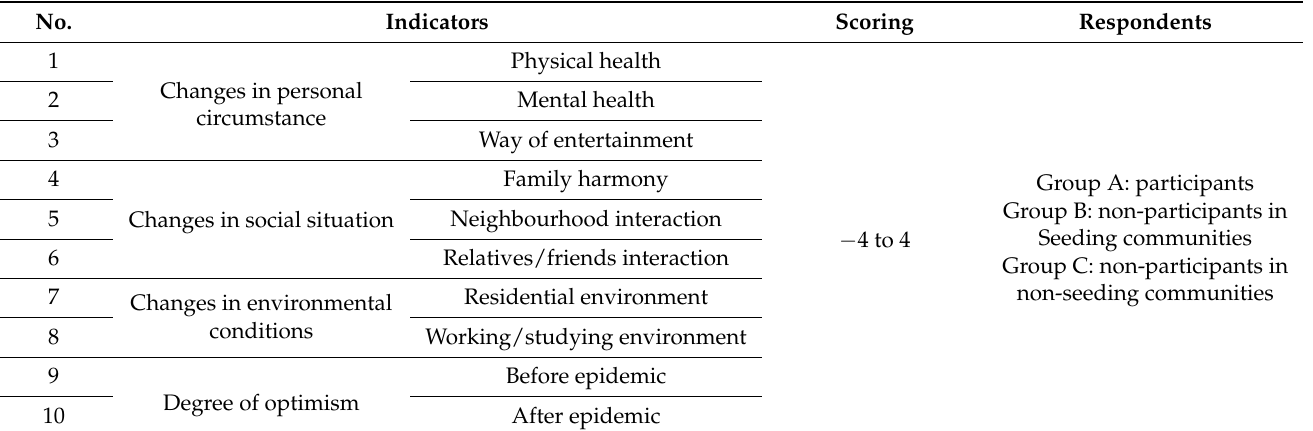
Table 1. Questionnaire